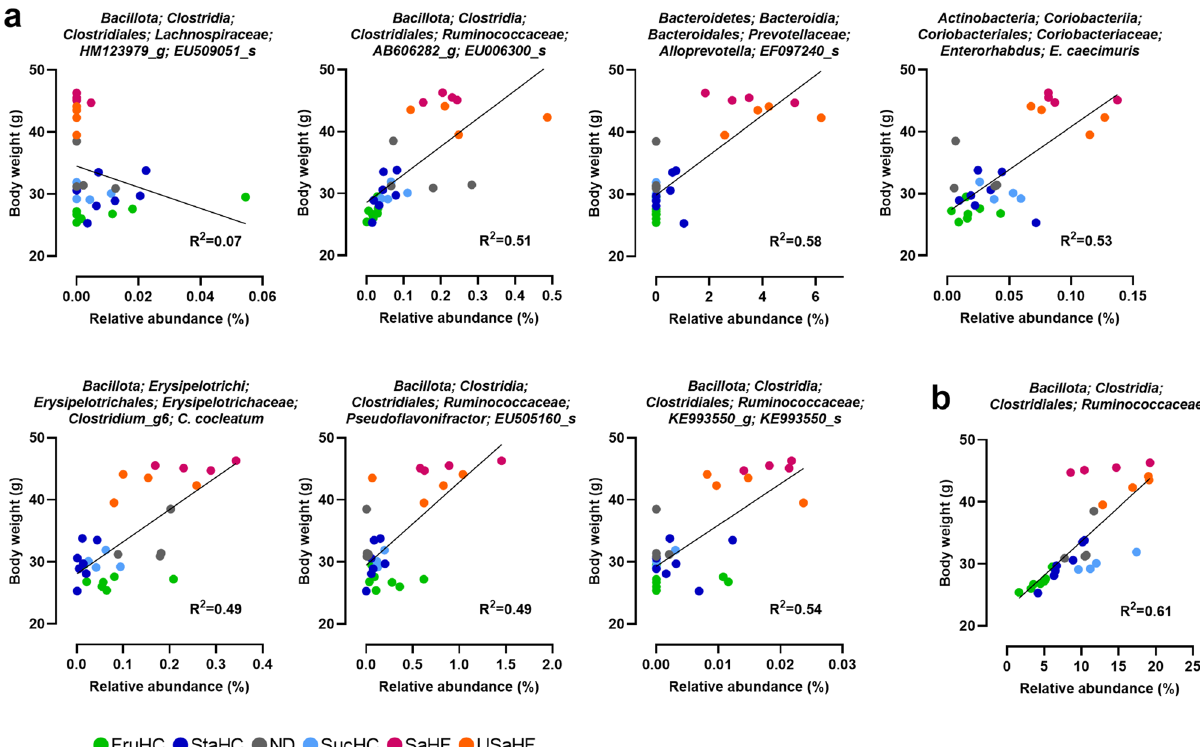
Figure 6. Body weight-associated microbiota. Correlation between the body weight and abundance of ( a ) microbiota species and ( b ) Ruminococcaceae . The lines were drawn via simple linear regression analysis. The colors of the dots indicate mice fed the following diets: gray, normal diet (ND); dark blue, high-starch diet (StaHC); light blue, high-sucrose diet (SucHC); green, high-fructose diet (FruHC); red, saturated fatty acid-rich high-fat diet (SaHF); and orange, unsaturated fatty acid-rich high-fat diet